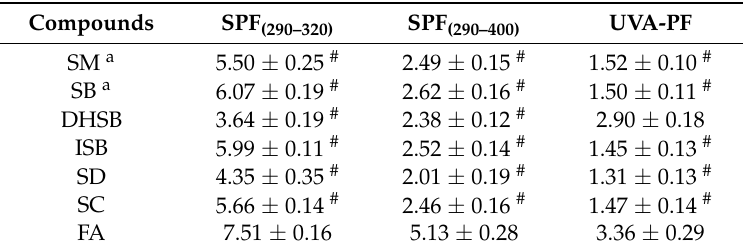
Table 3. Sun and UVA protection factors of silymarin and flavonolignans. Compounds